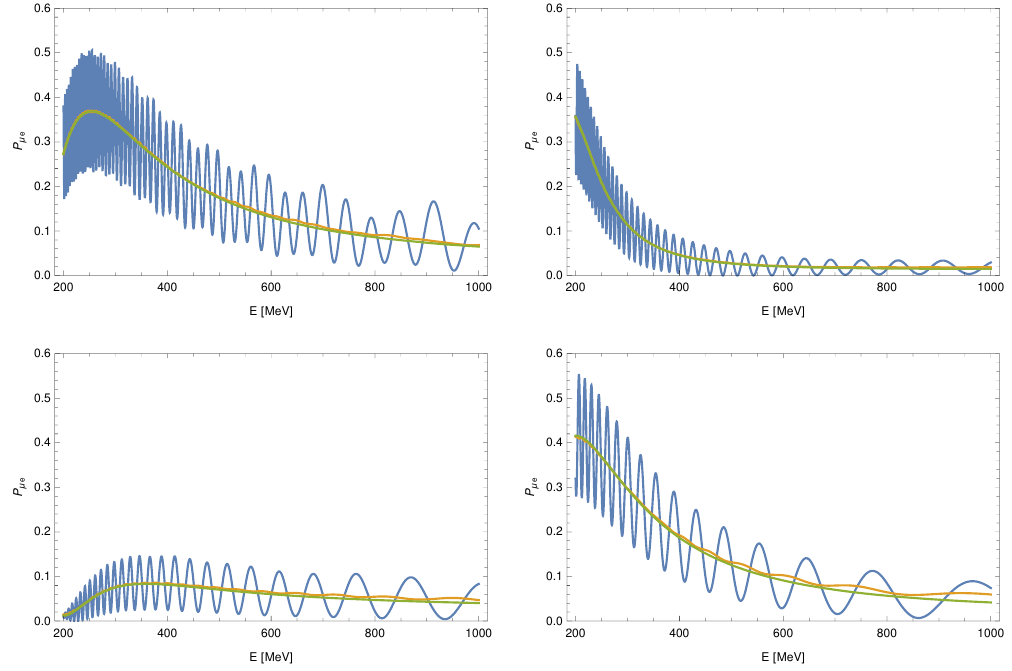
Figure 10 . Oscillation probabilities for (cid:23) (cid:22) ! (cid:23) e transitions for the CP-phase (cid:14) = (cid:25)= 2 as a function of neutrino energy (in MeV) and di(cid:11)erent azimuthal angles. Blue line: P (cid:22)e ( E; (cid:18) ), yellow line: ^ P (cid:22)e ( E; (cid:18) ), green line: (cid:22) P (cid:22)e ( E; (cid:18) ). Upper left/right panels: (cid:18) = (cid:25)= 10 and (cid:18) = (cid:25)= 4, respectively. Lower left/right panels: (cid:18) = (cid:25)= 3 and (cid:18) = (cid:25)= 2 : 5. Normal mass ordering is assumed.